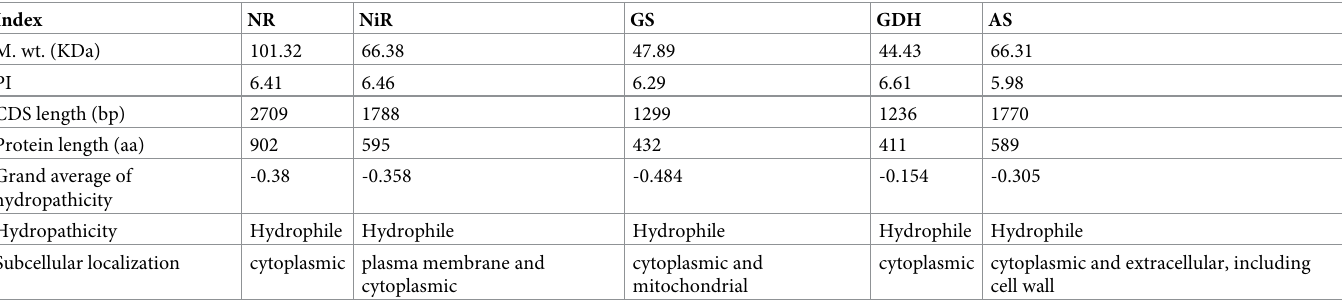
Table 5. List of proteins and their molecular weight (M. wt.), isoelectric point (PI), CDs and protein length, hydropathicity and subcellular